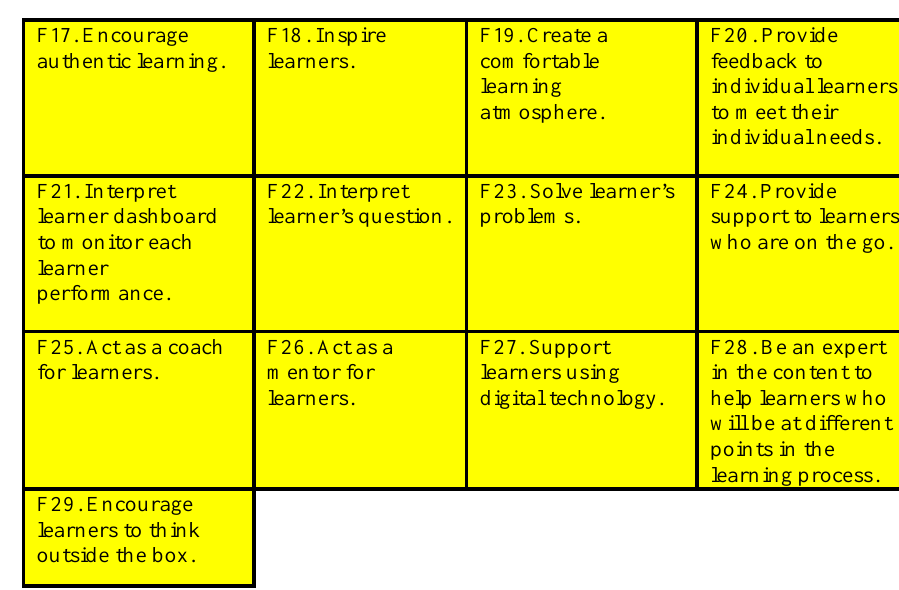
Figure 8. Facilitation competencies for the digital teacher.